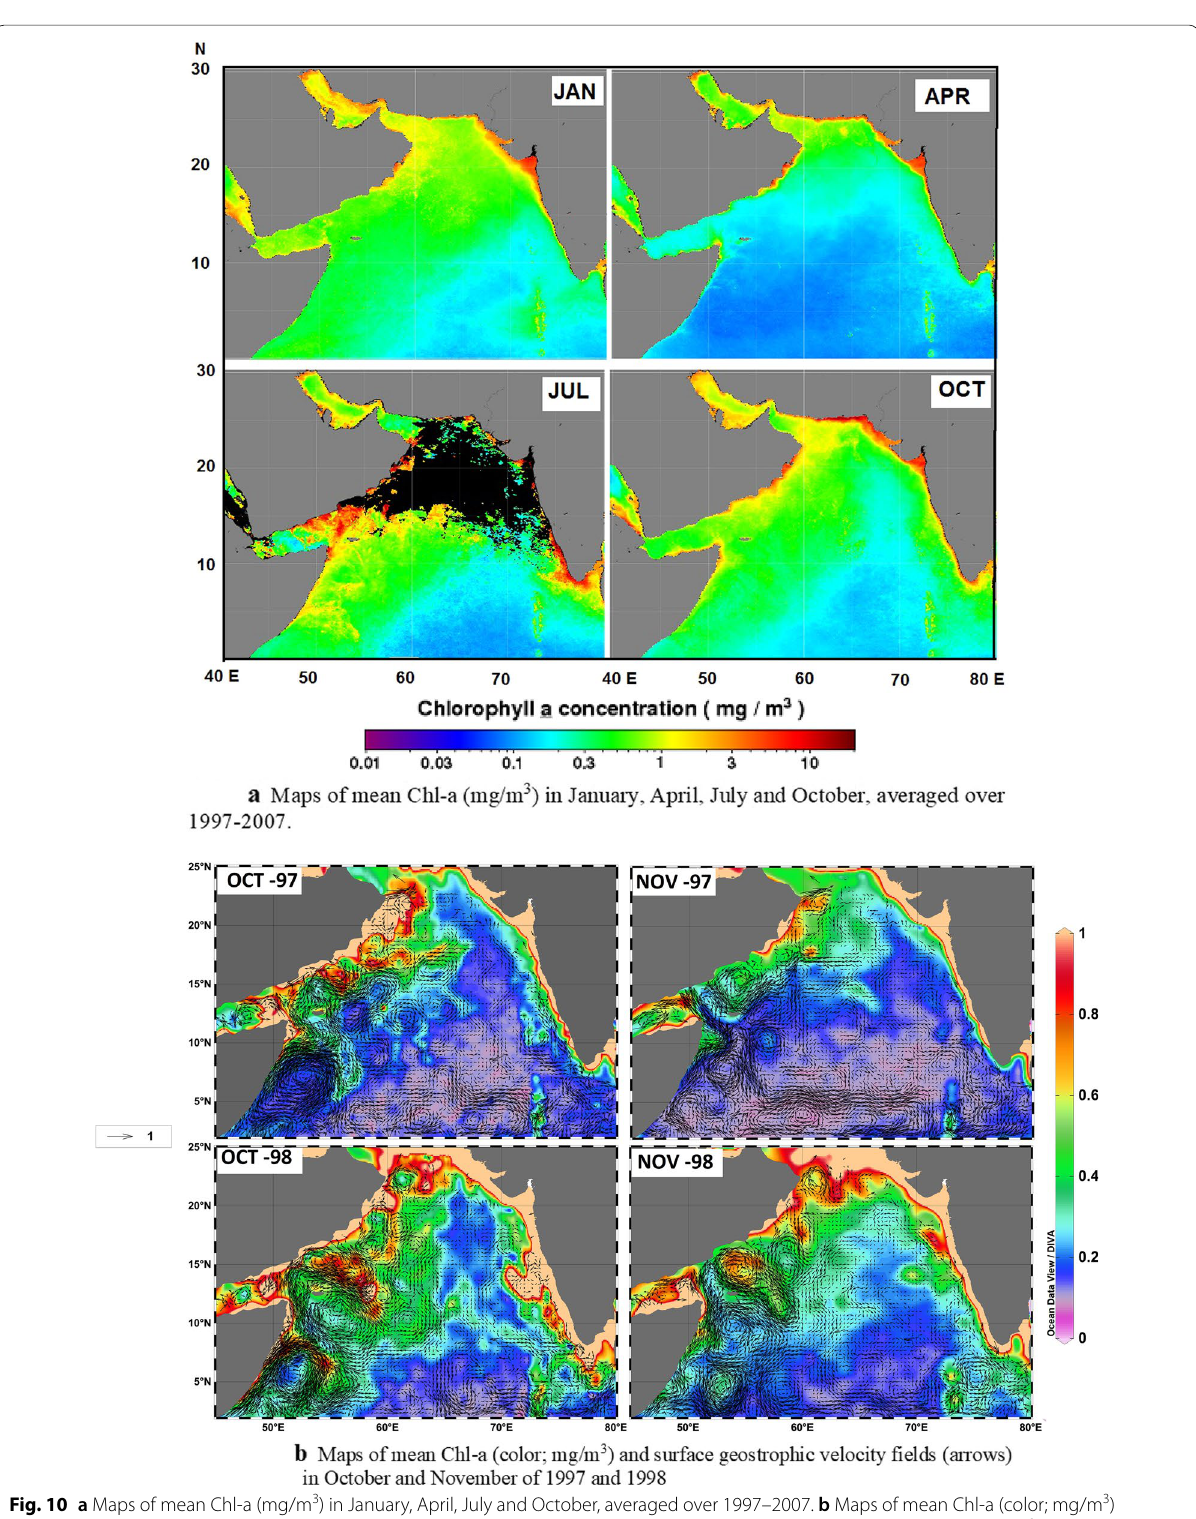
Fig. 10 a Maps of mean Chl-a (mg/m 3 ) in January, April, July and October, averaged over 1997–2007. b Maps of mean Chl-a (color; mg/m 3 ) and surface geostrophic velocity fields (arrows) in October and November of 1997 and 1998. c Maps of mean Chl-a (color; mg/m 3 ) and surface geostrophic velocity fields (arrows) in the western AS in October and November of 1997 and 1998. d Maps of mean wind fields (m/s) in the western AS in October of 1997 and